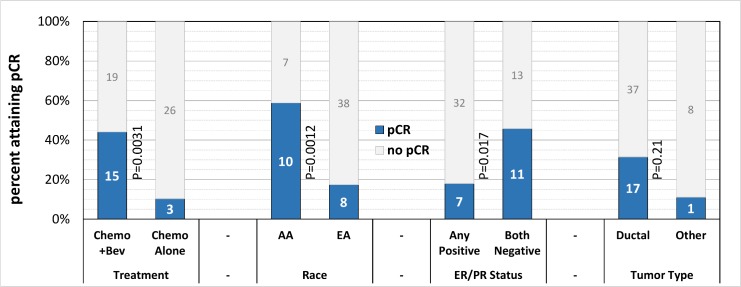
Rates of pCR by Treatment cohort, Race, Hormone-receptor status, and Tumor type among genotyped subjects.Stacked barchart showing how the number and proportion of pCRs varies by treatment cohort, by race, by ER/PR Status, and by tumor type. Group labels appear below their bars. P-values are from chi-square tests comparing groups for pCR differences.